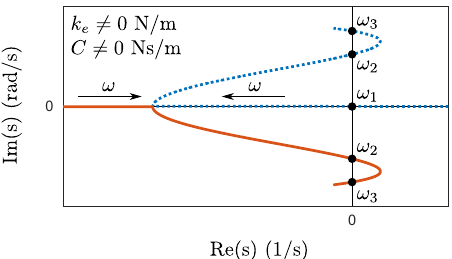
Figure 3. Root locus of both relevant eigenvalues: ( a ) evolution with the damping C = { 0,0.5,1 } Ns/m for k e = 0 N/m; and ( b ) evolution with the external stiffness | k e | = { 0, 1 C = 0 Ns/m.